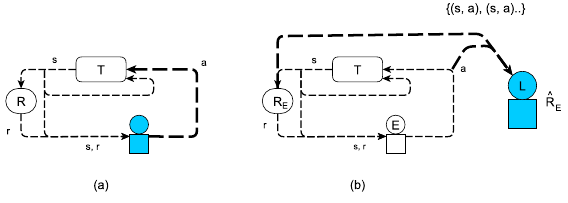
Figure 2. Reinforcement learning (a) and inverse reinforcement learning (b).